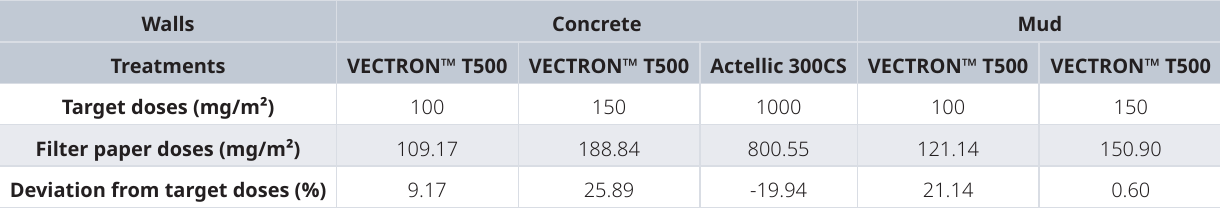
Table 4. Insecticide application quality results obtained by filter papers treated during the huts spraying analysis. Walls